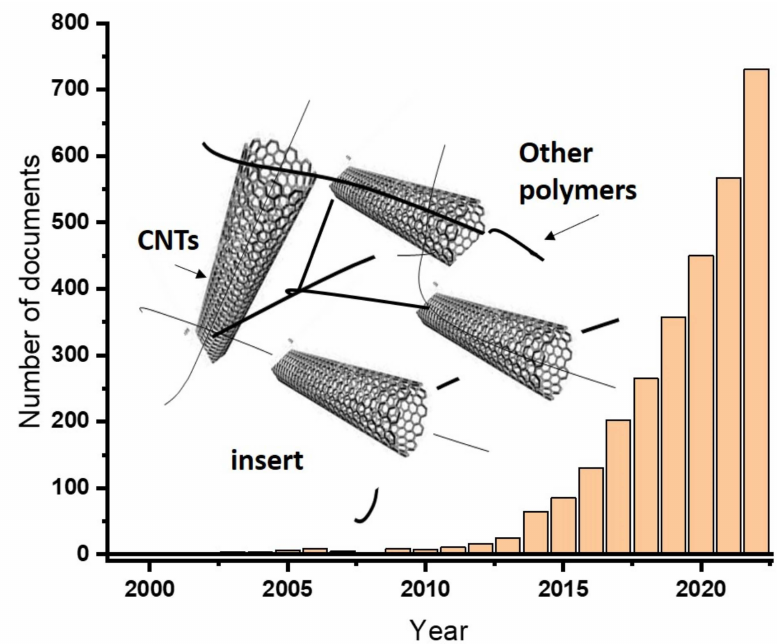
Figure 6. The increasing trends on the use of carbon nanotubes in the production of supercapacitors searched on the topic of “carbon nanotube-based hydrogels for supercapacitor applications” (as obtained from ScienceDirect databases (accessed on 12 December 2022). The insert representing the hydrogels is formed by CNTs.